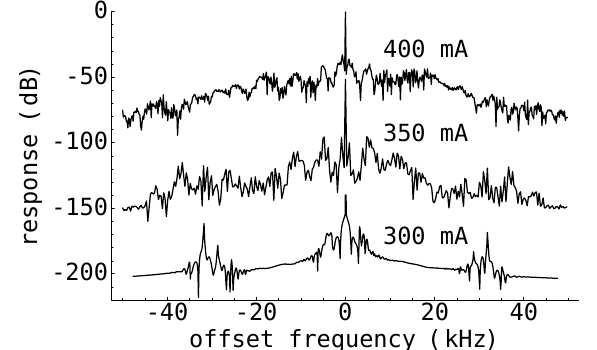
FIG. 7. Spectrum of simulated microwave-unstable bunches in the NSLS VUV ring at three beam currents. The ring impedance is that of a Q (cid:1) 1.118 resonator with j Z n (cid:3) n j (cid:1) 1.84 V and resonant frequency 2.0 GHz. Successive traces are displaced vertically 50 dB. Machine parameters are given in Table I.